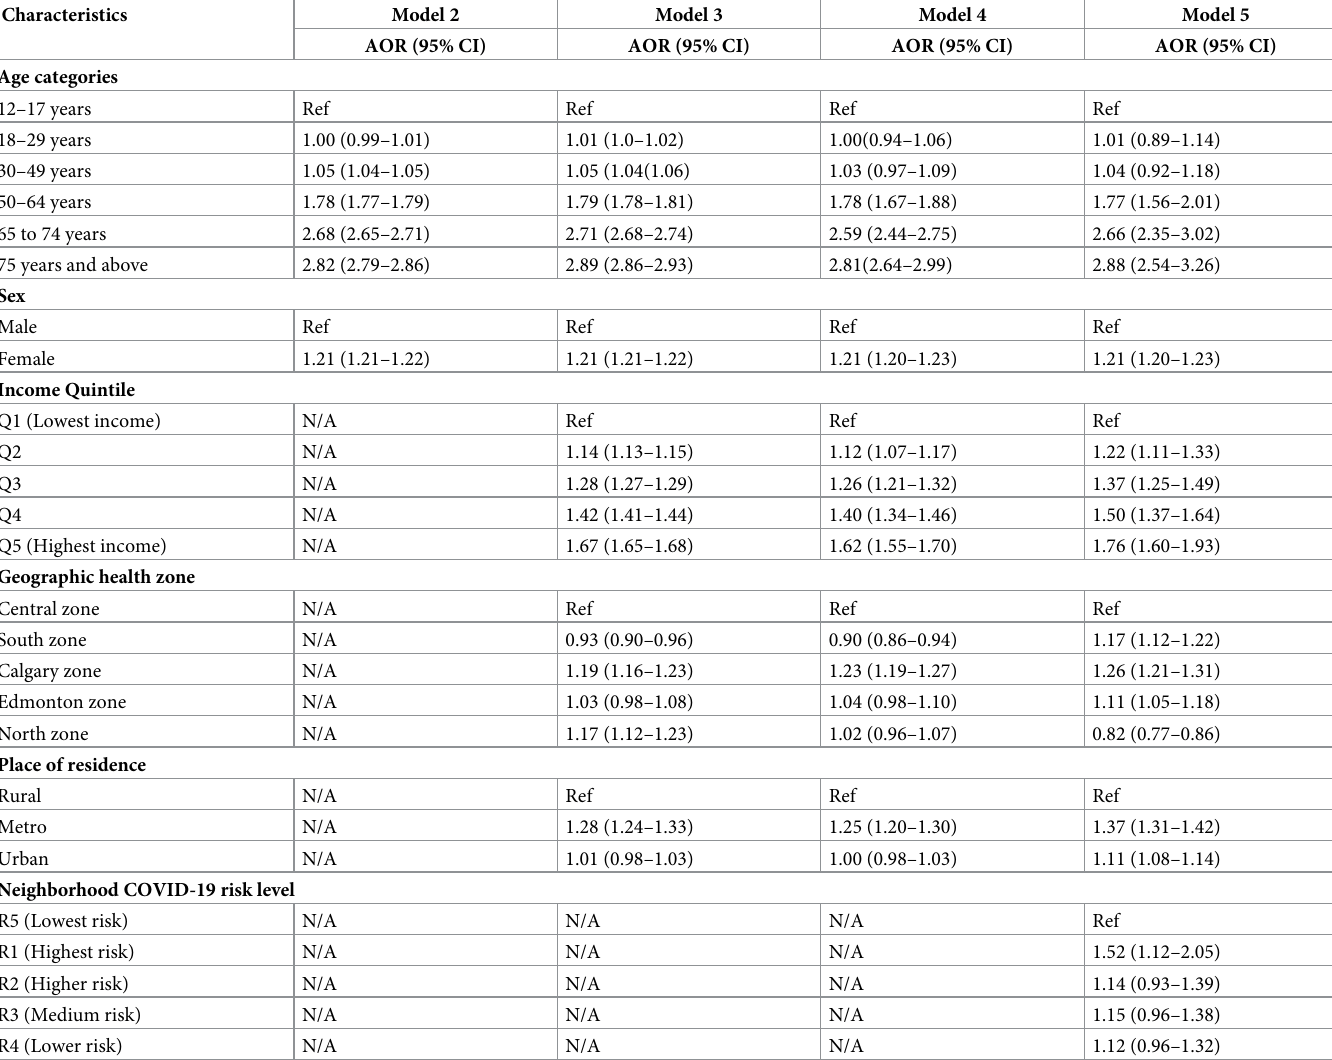
Table 2. Multilevel logistic regression analysis of factors associated with receipt of one dose of COVID-19 vaccine in Alberta, Canada a .